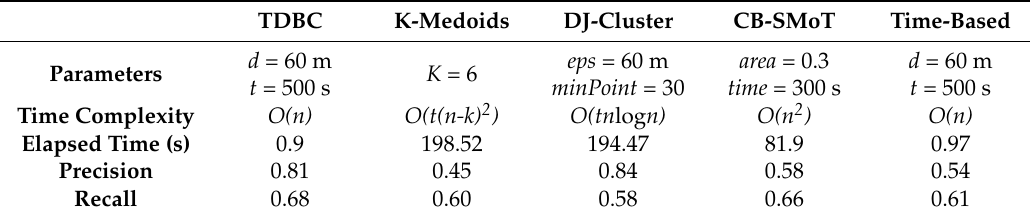
Table 2. Results of different cluster algorithms for Dataset